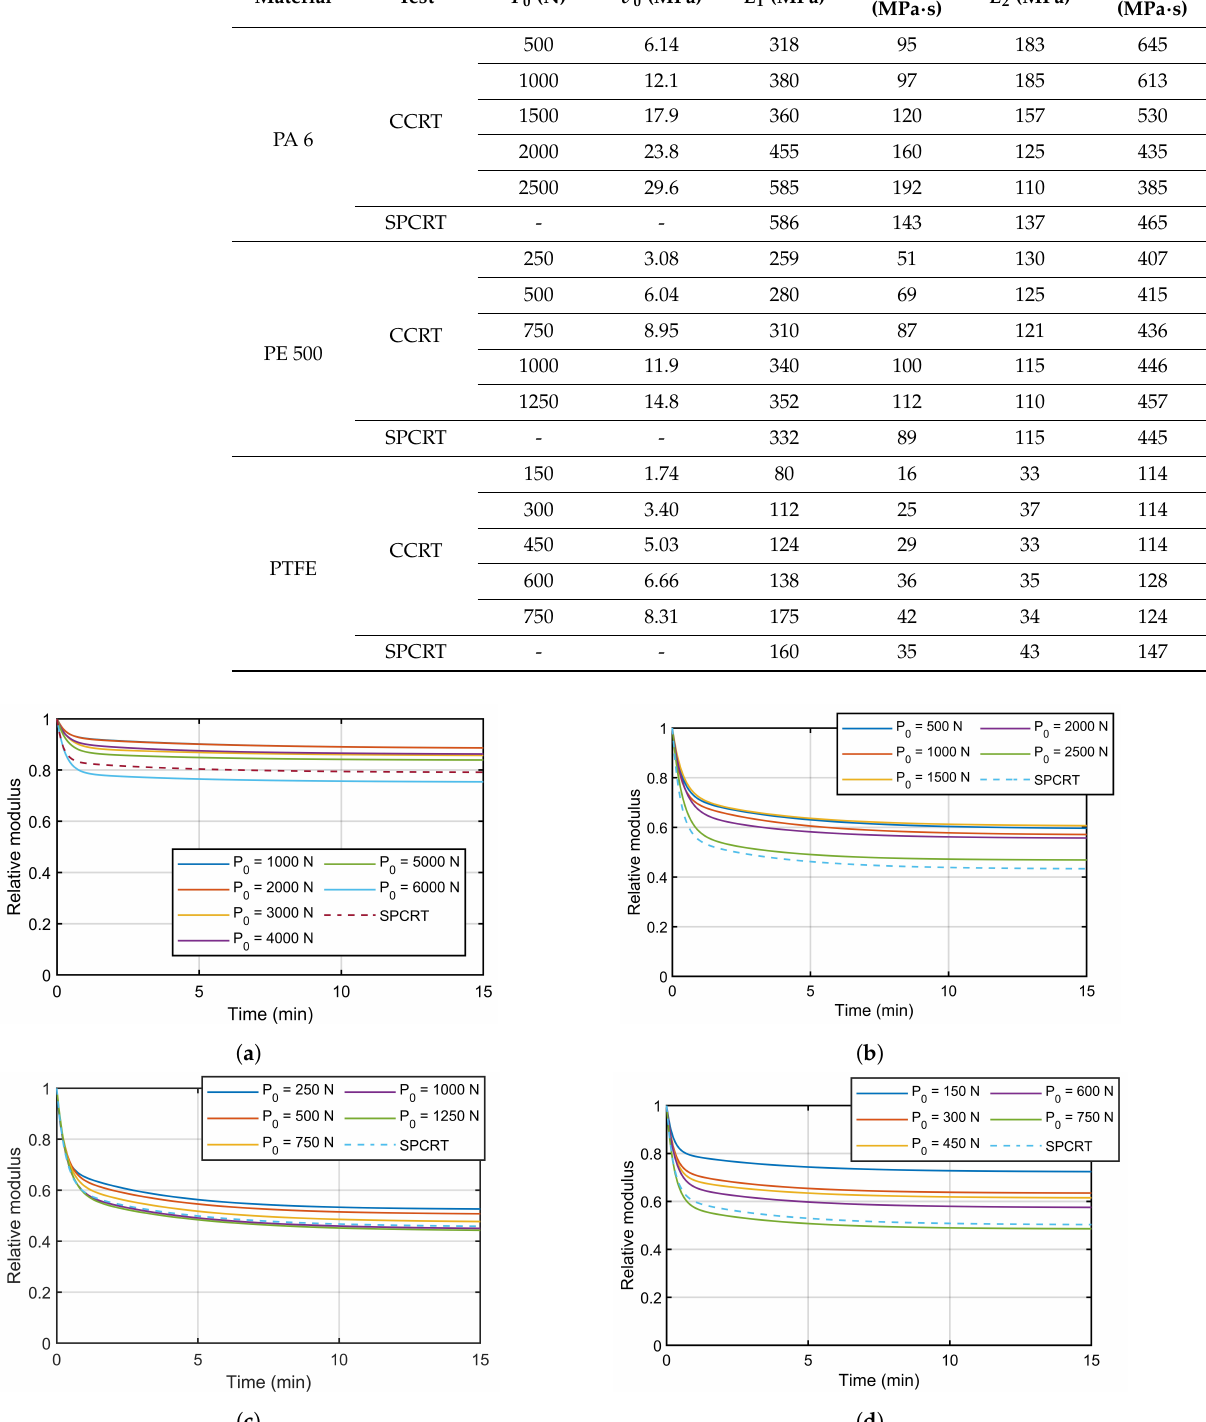
Figure 10. Relative modulus κ ( t ) : ( a ) POM C, ( b ) PA 6, ( c ) PE 500, and ( d )